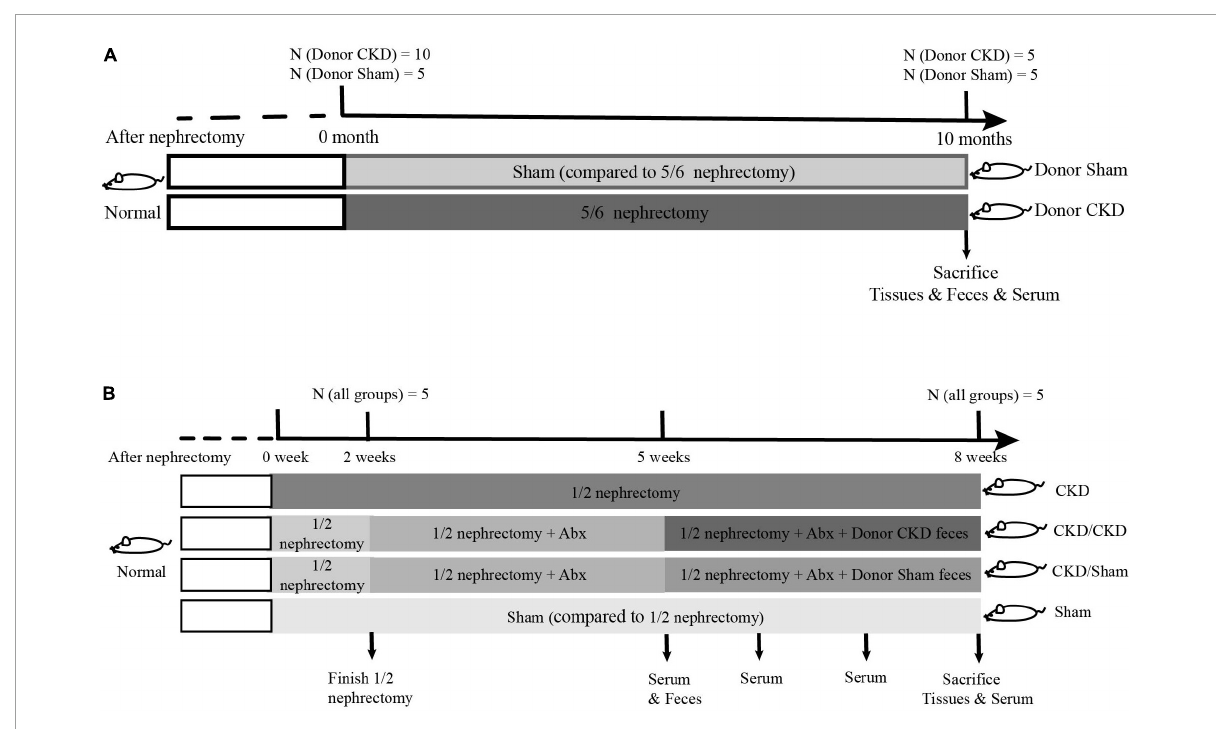
FIGURE1 The graphical scheme of the animal experiment. (A) Preparation of donor-rats for fecal microbiota transplantation. (B) Experimental design of fecal microbiota